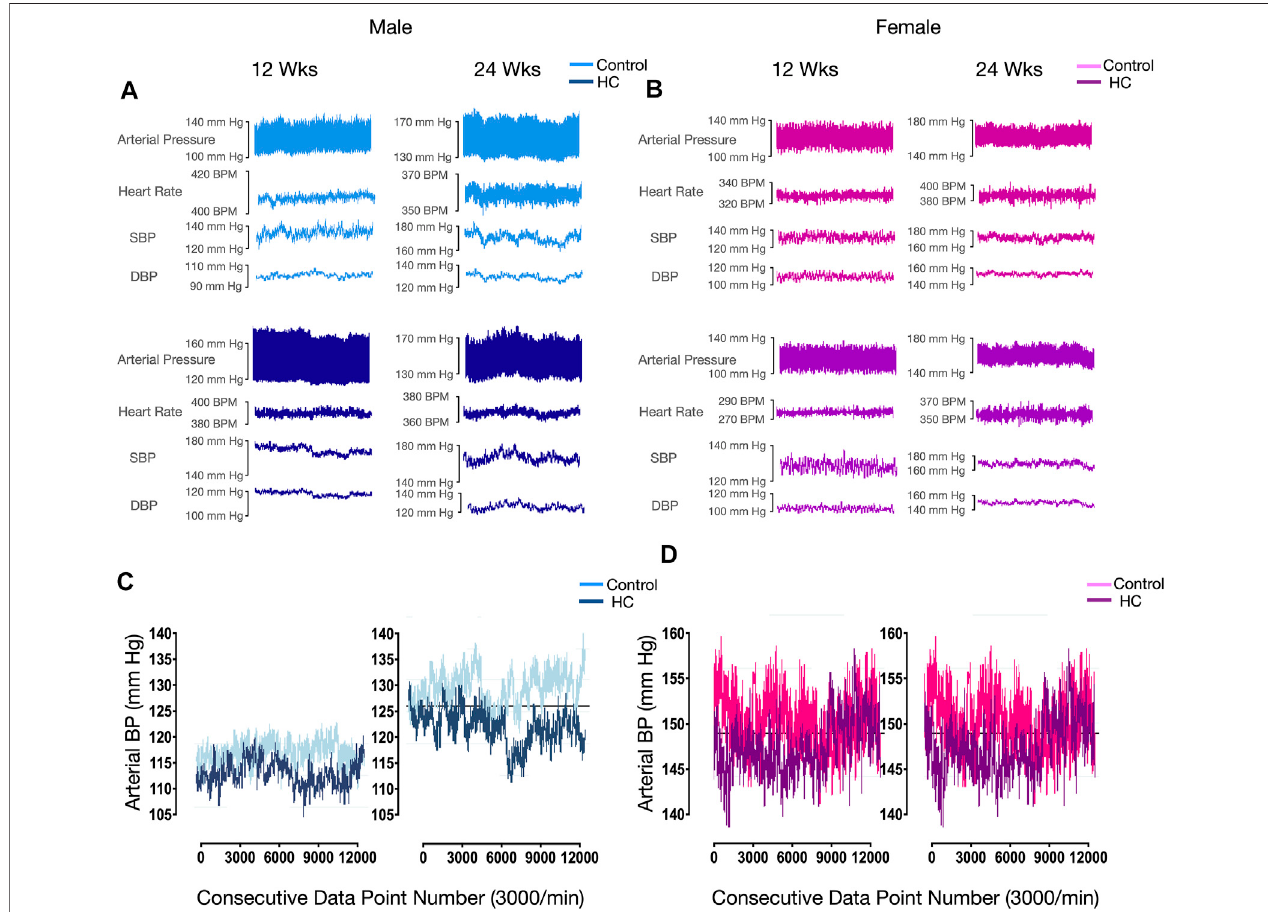
FIGURE 4 | Representative beat-to-beat blood pressure and heart rate tracings of selected rats. Raw arterial pressure, heart rate, and systolic and diastolic blood pressure recordings in 12-week and 24-week control and HC-fed (A) male and (B) female rats. (C) Downsampled beat-to-beat diastolic blood pressure (BP) tracing of controlandHC-fedmaleratsofdifferentfeedingdurationgroupsshowingequalaverage,SD,andCVvaluesforallgroupswithreducedApEnvaluesin12-weekHC-fed rats. (D) Beat-to-beat systolic blood pressure (BP) tracing of control and HC-fed female rats of different feeding duration groups showing equal average, SD, and CV values for all groups with reduced ApEn and α values compared to male rats.